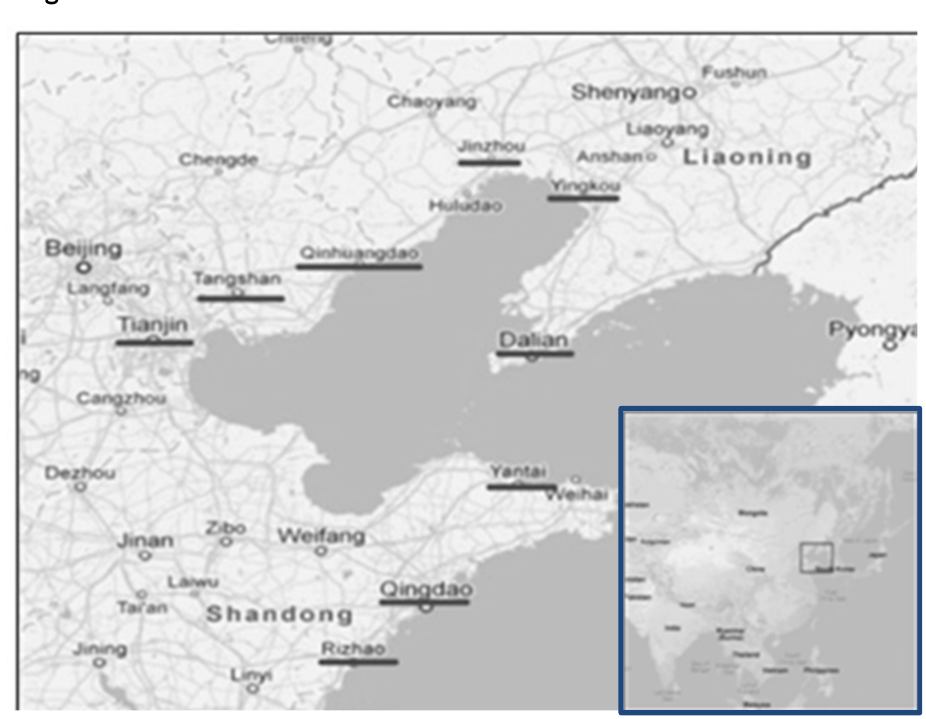
Figure 1. Bohai Economic Rim with Selected Nine Ports